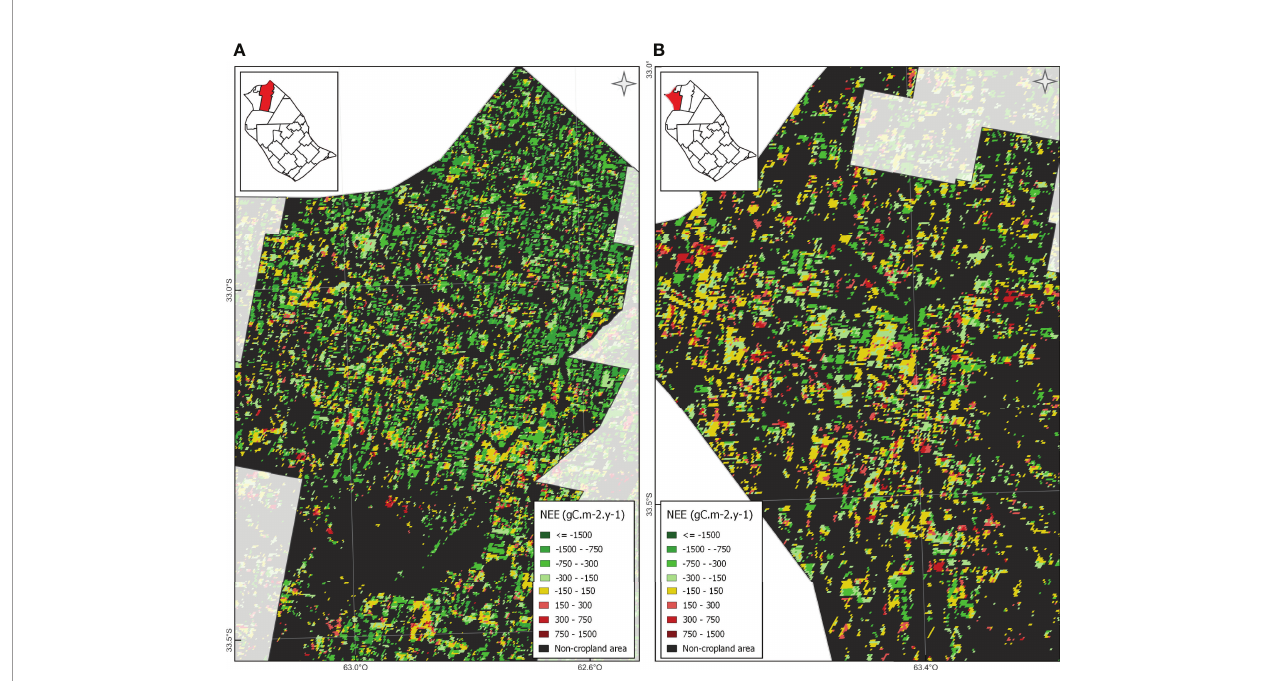
FIGURE 6 | Detailed NEE in Union (A) and Juarez Celman (B) counties in the northern Inland Pampa during the 2019 – 2020 cropping